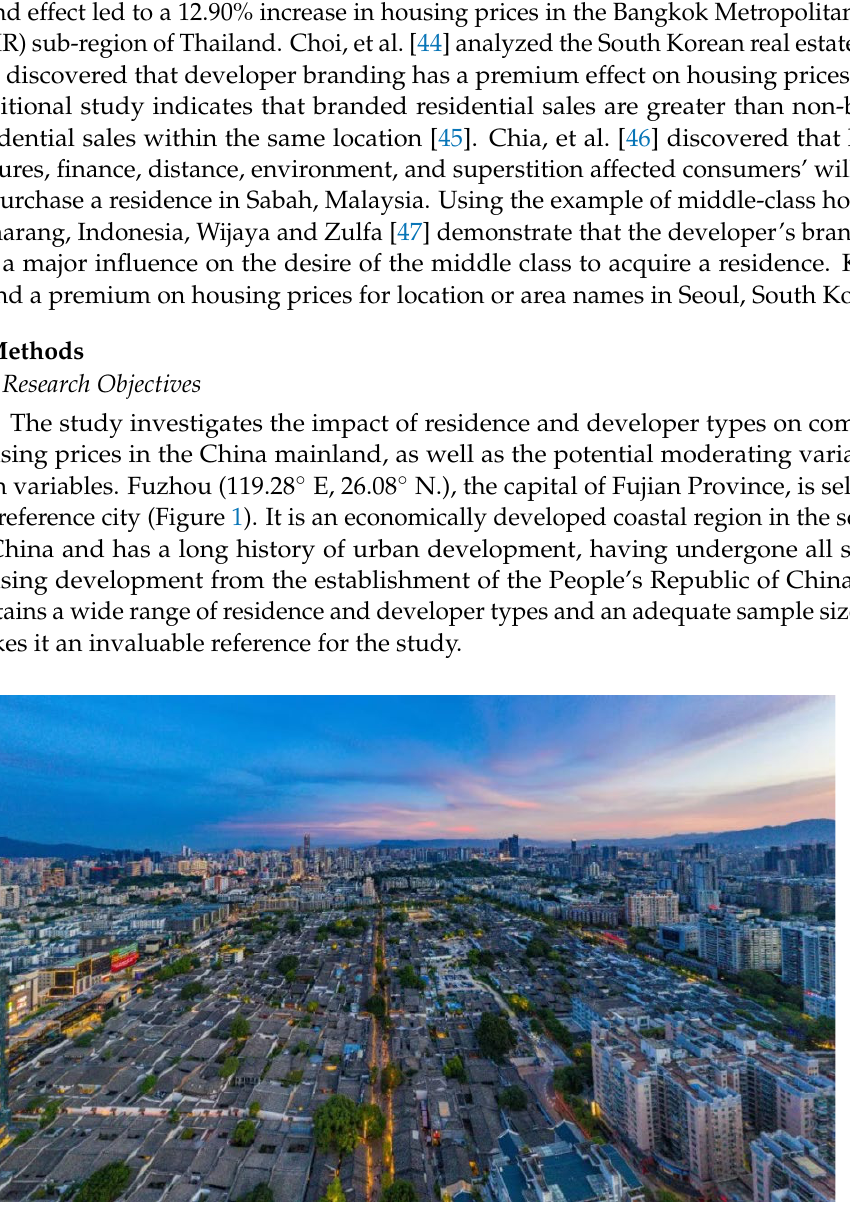
Figure 1. Aerial view of the city proper of Fuzhou.